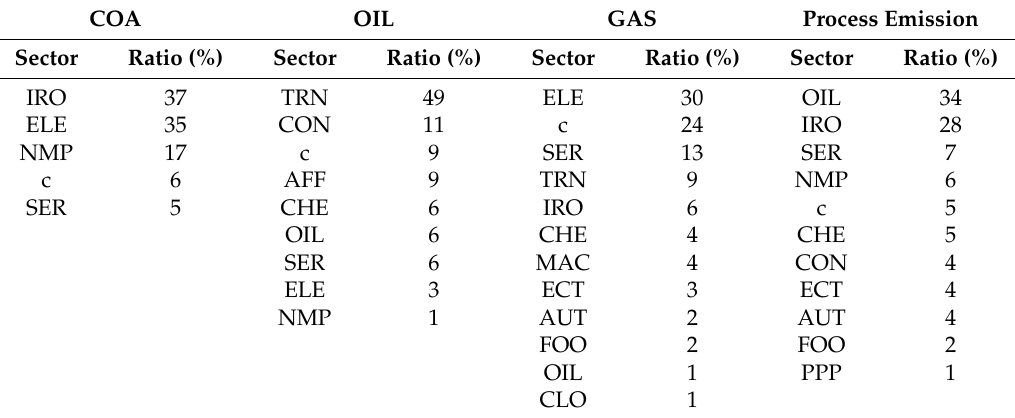
Table 5. PM 2.5 emission ratio by source and